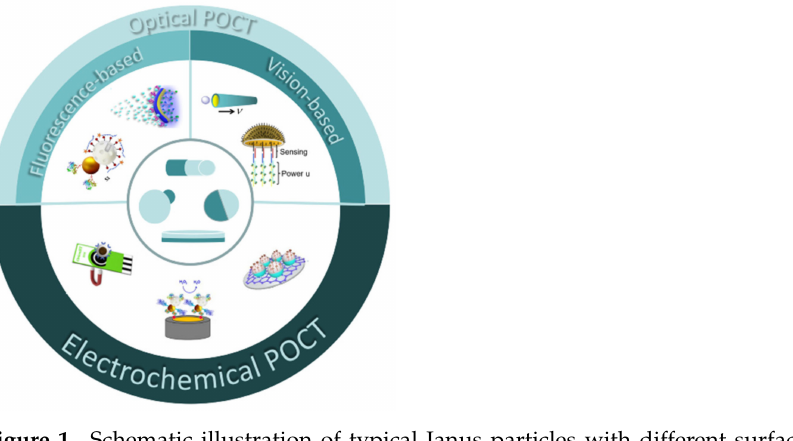
Figure 1. Schematic illustration of typical Janus particles with different surface properties and various